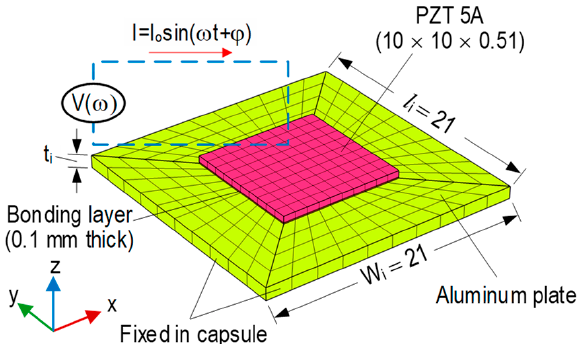
Figure 5. FE model of PZT-mounted interface in CSA (dimension in mm). Table 1. Material properties of aluminum, bonding layer, and PZT patch.